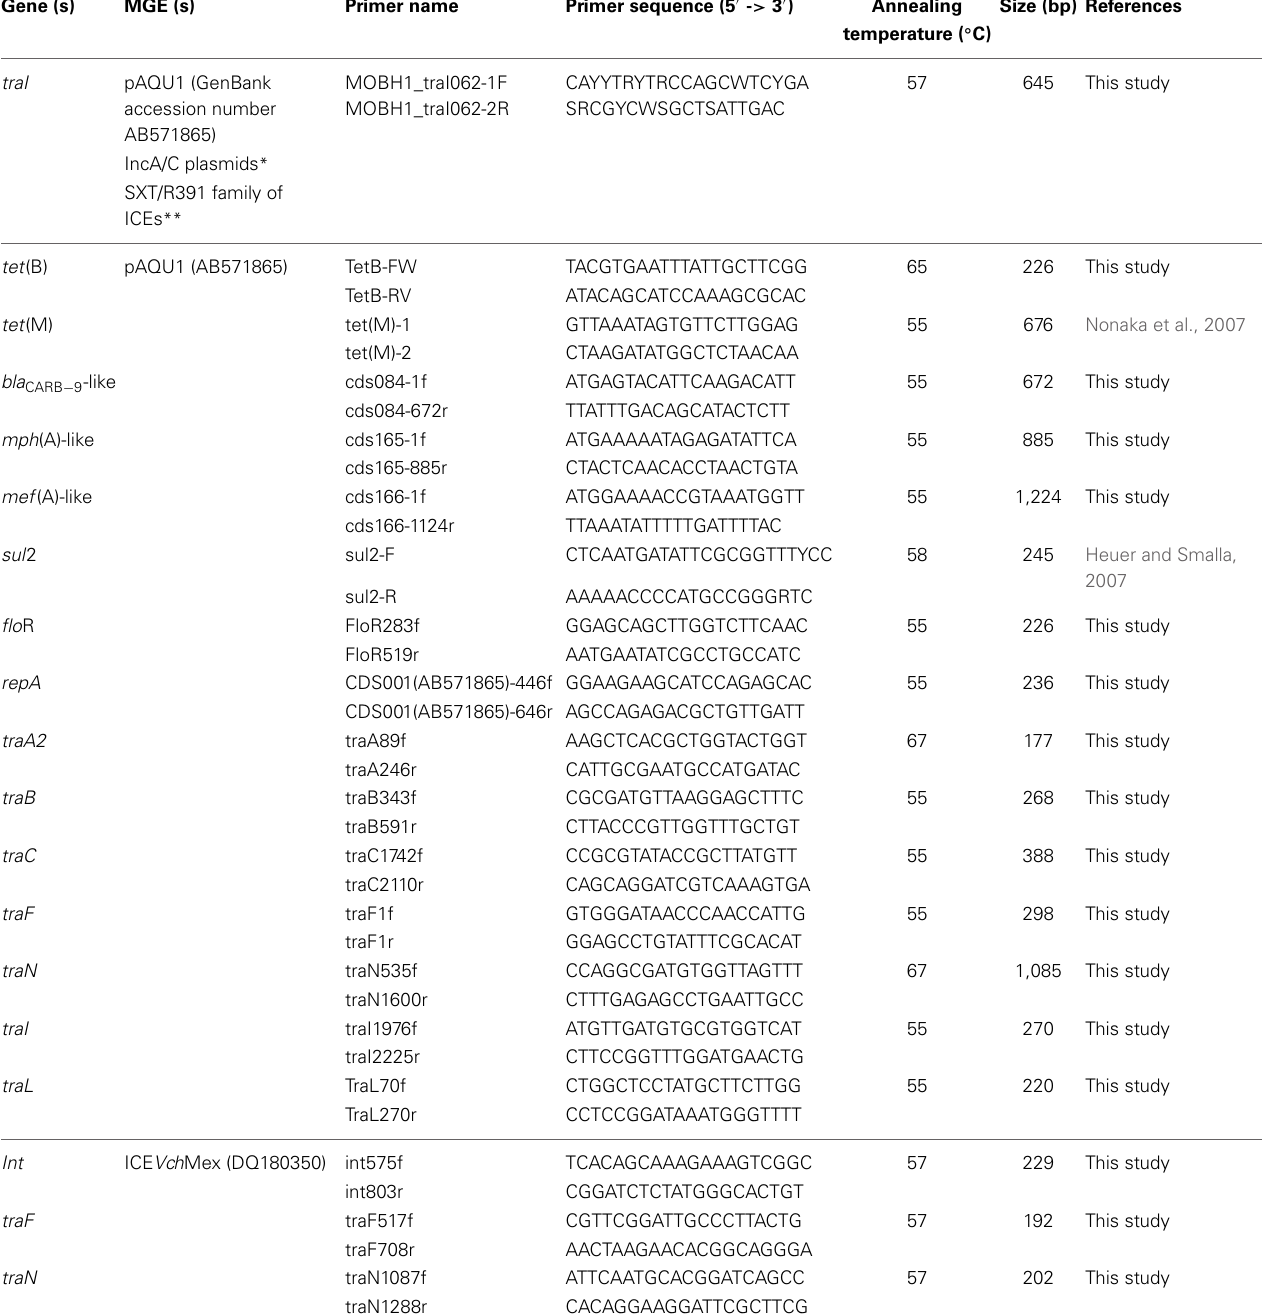
Table 1 | PCR primers used in this